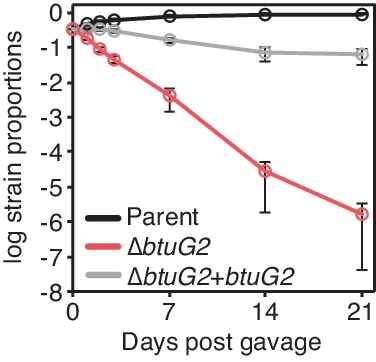
A BtuG homolog is required for B. thetaiotaomicron fitness in gnotobiotic mice.B. thetaiotaomicron parent, ∆btuG2 and complemented (∆btuG2 + btuG2) strain ratios determined from gDNA extracted from fecal samples of gnotobiotic mice collected over time. (n = 5 mice; error bars indicate ± SD). The fitness defect of a B. thetaiotaomicron strain lacking btuB2 (Figure 1F) is also complemented by expression of btuB2 in single copy from a heterologous chromosomal locus (Degnan et al., 2014a).